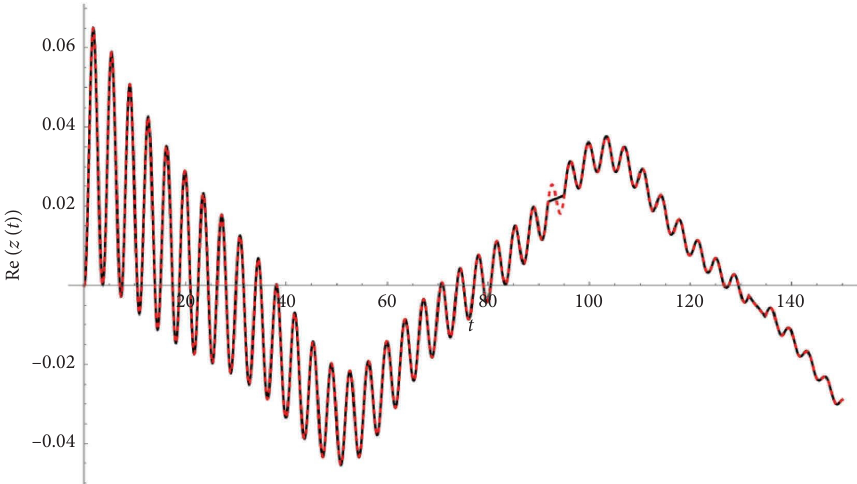
Figure 1: Real part compared with the Runge–Kutta numerical solution.